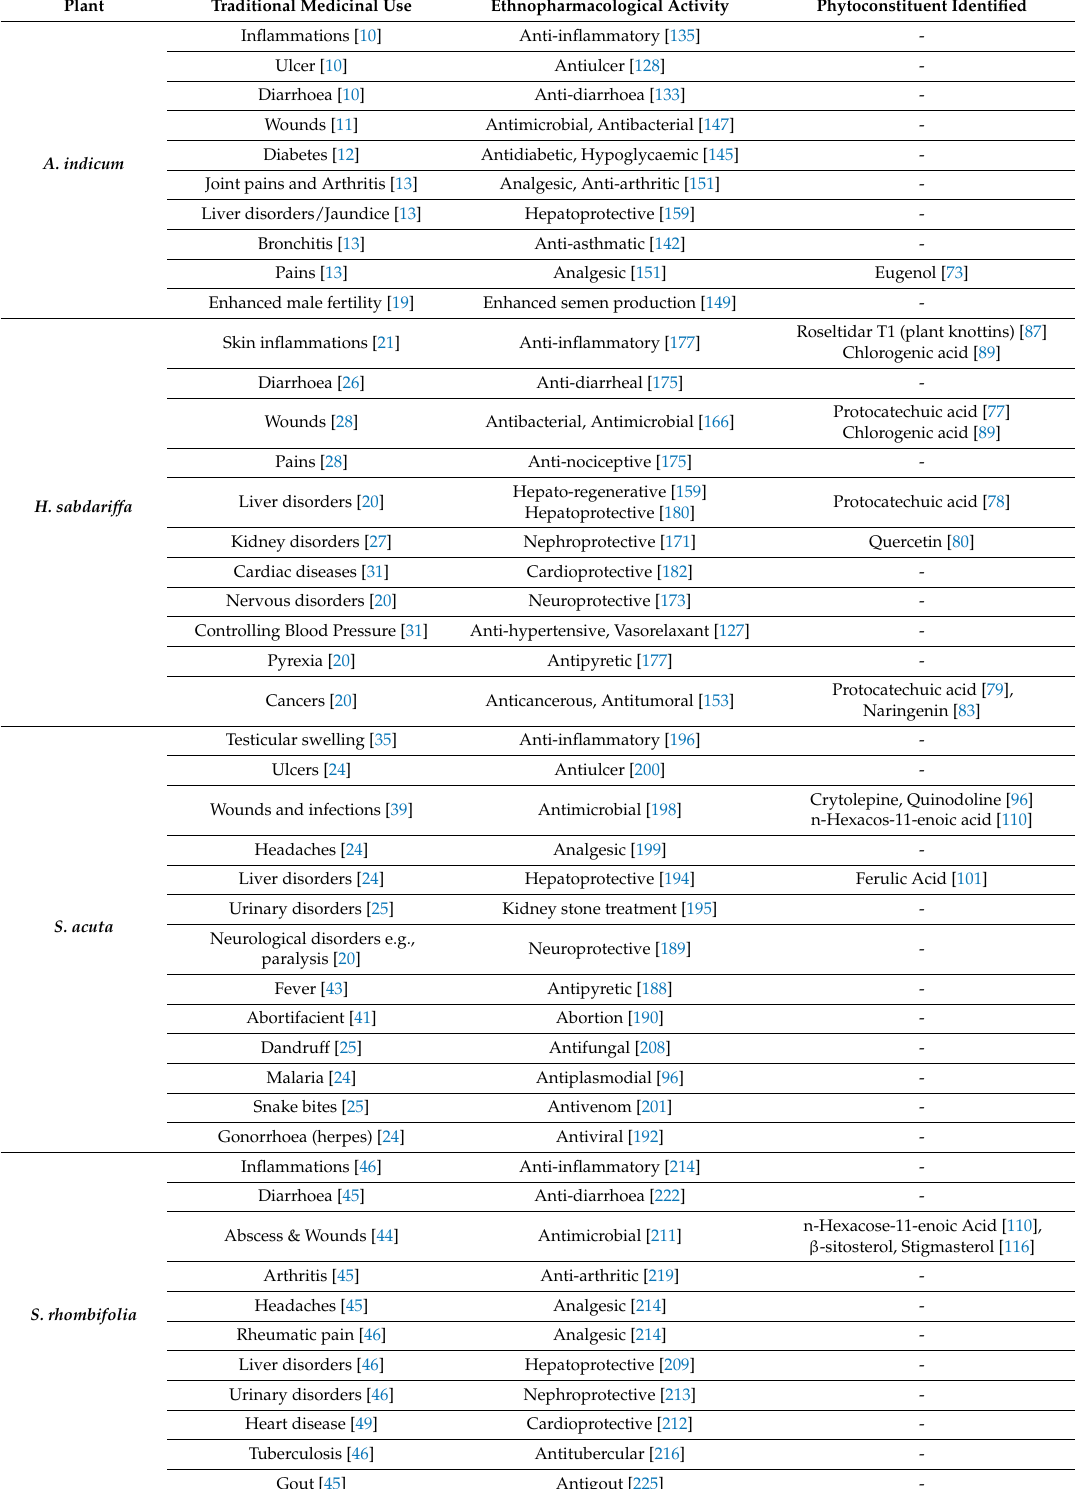
Table 4. Justification of traditional medicinal uses of Abutilon indicum , Hibiscus sabdariffa , Sida acuta and Sida rhombifolia supportedby scientific investigations of their ethnopharmacological activities and phytoconstituents (‘-‘ indicates not